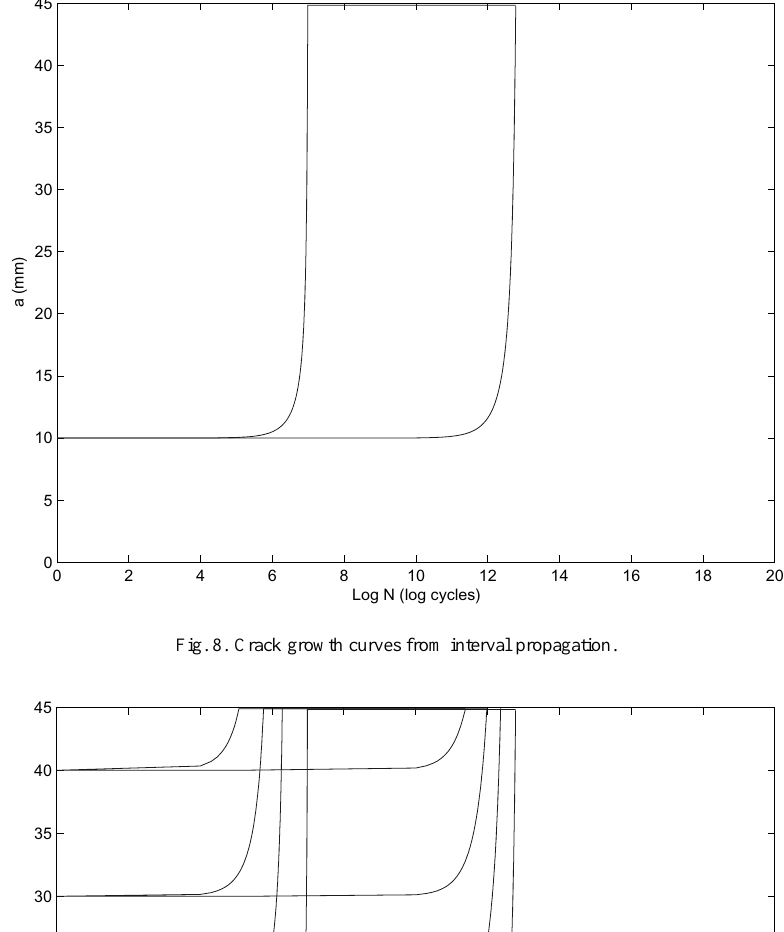
Fig. 8. Crack growth curves from interval propagation.